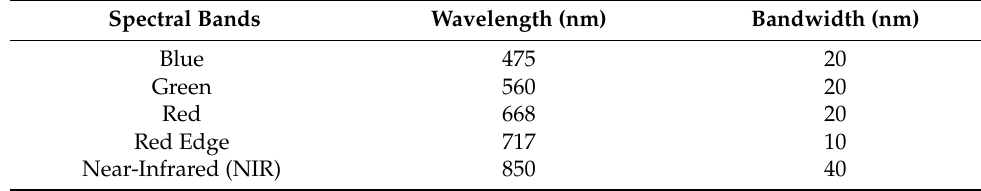
Table 1. Micasense 5-band multispectral sensor wavelengths.